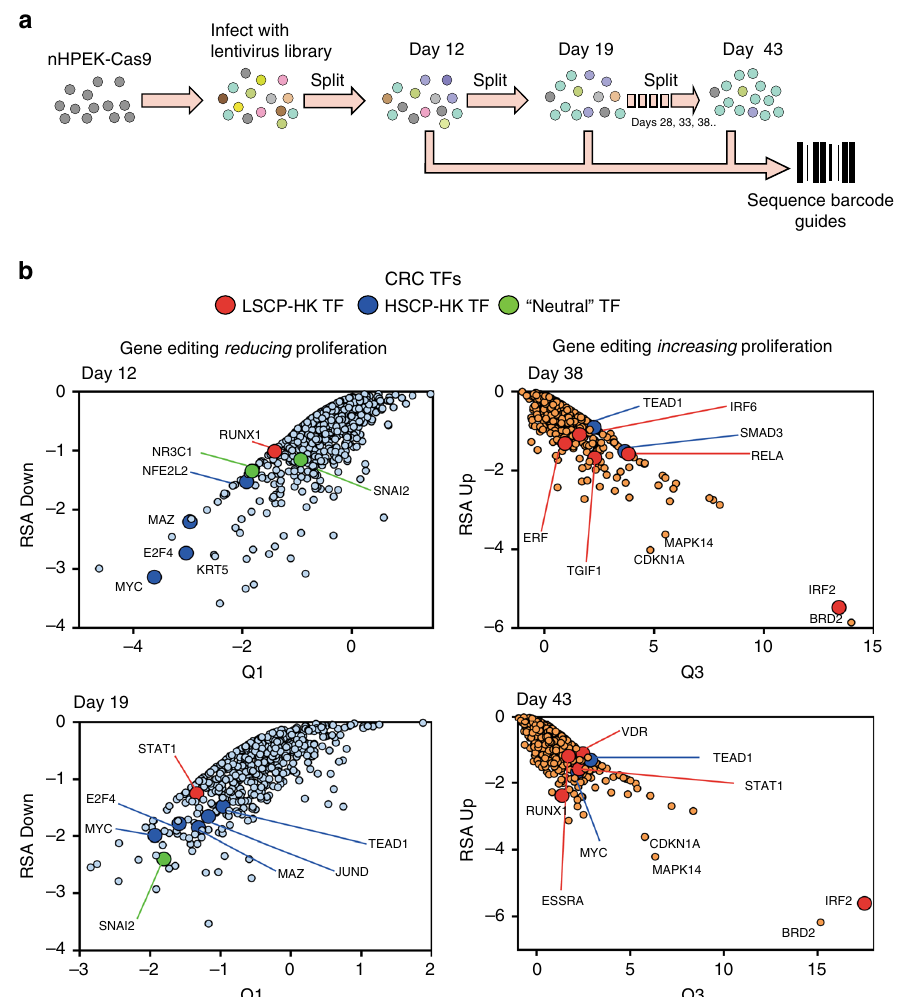
Fig. 4 CRISPR – Cas9 screen con fi rms CRC-TFs ’ role in keratinocyte stem cell fate. a Schematic depicting pooled screening approach in Cas9-expressing neonatal HPEKs (nHPEK-Cas9) infected with sgRNA library (at day 0) followed by puromycin selection and collection of cell pellets at days 12, 19, 28, 33, 38 and 43 post infection after split. Abundance of sgRNA sequences was quanti fi ed by deep sequencing of the corresponding barcodes in the genomic DNA of the different cell pellets. b Gene level results of pooled screen at days 12, 19, 38, and 43, plotting z -score (Q1 or Q3) versus redundant siRNA activity (RSA Down or RSA Up). Q1 versus RSA Down at Days 12 and 19 identi fi es gene editing that reduces proliferation while Q3 versus RSA Up at Days 38 and 43 identi fi es gene editing that increases proliferation. The top 7 Core Regulatory Circuitry (CRC) TFs (from Fig. 3d) are highlighted and marked as associated with either HSCP (blue), LSCP (red), or “ neutral